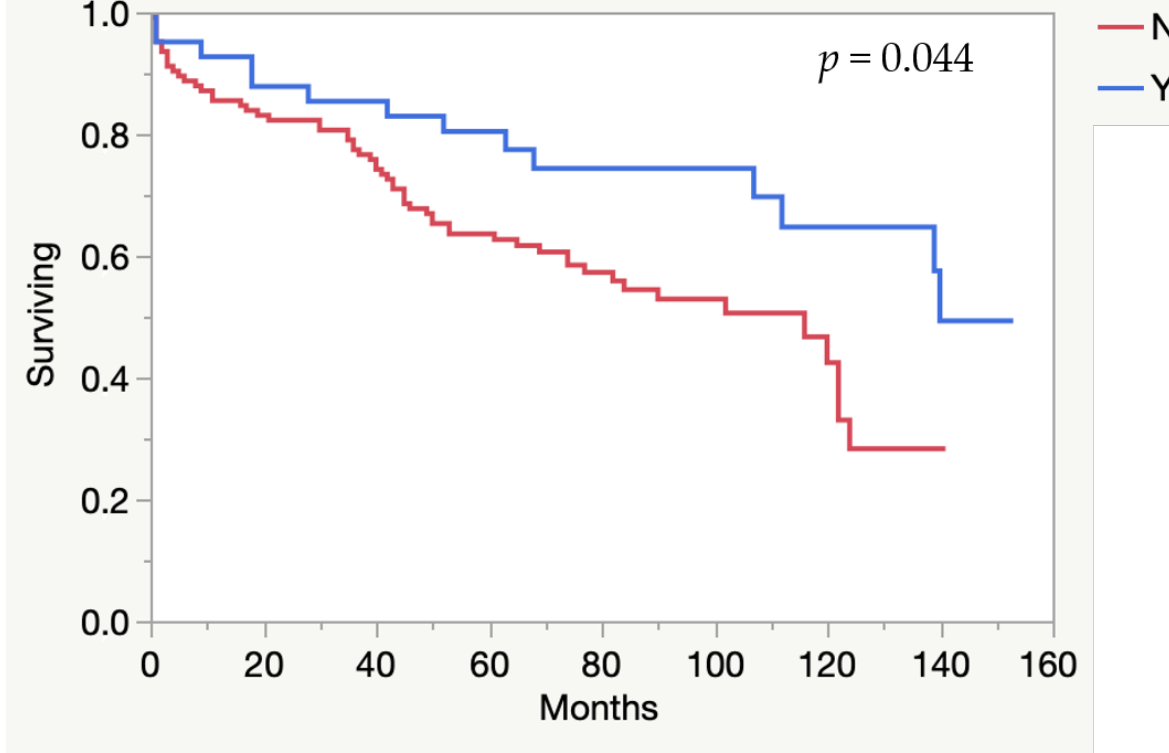
Figure 3. Long-term survival for patients with >2 CIED procedures performed (Yes) and ≤2 procedures (No).